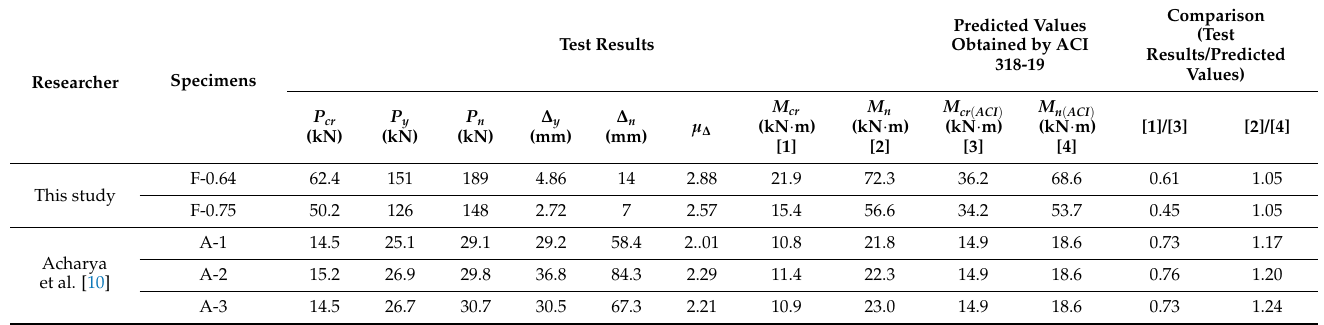
Table 4. Test results for the specimens governed by flexure.